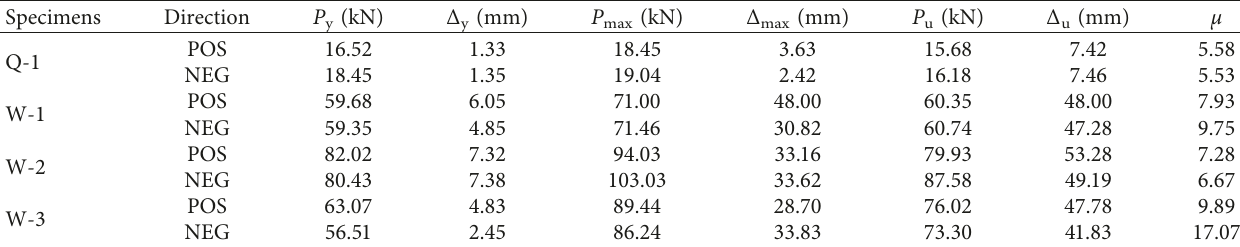
Table 5: Displacement ductility values of tested specimens.